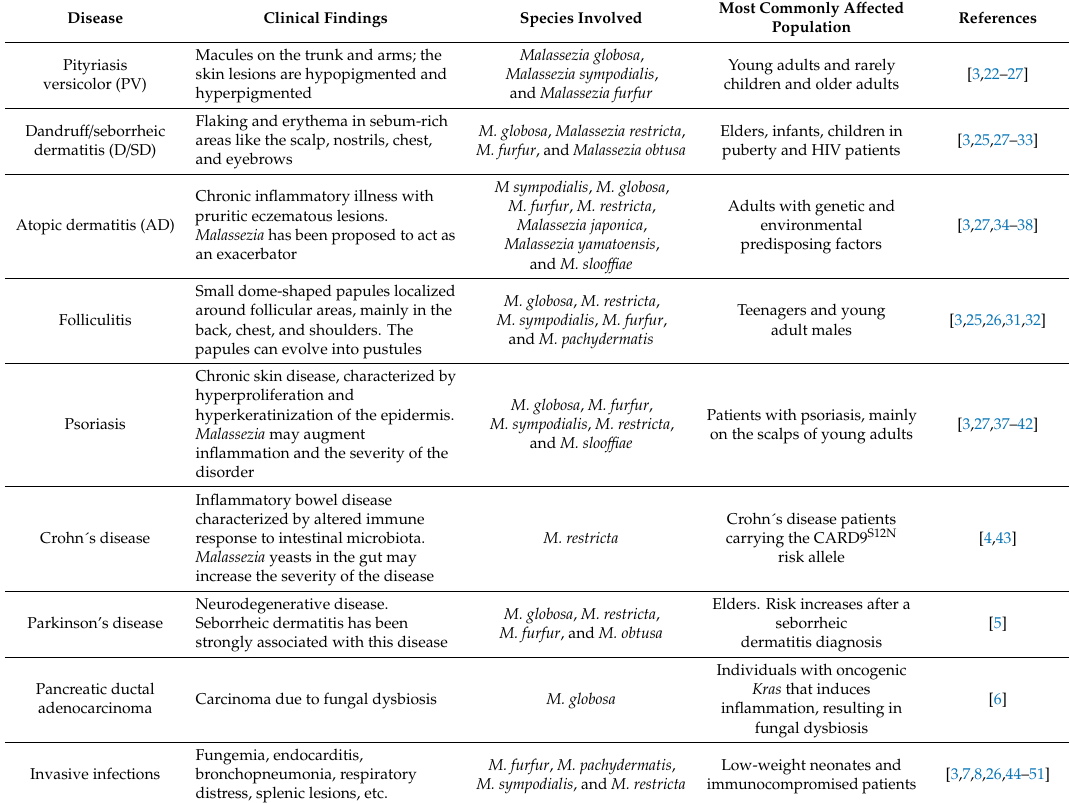
Table 1. Diseases associated with Malassezia